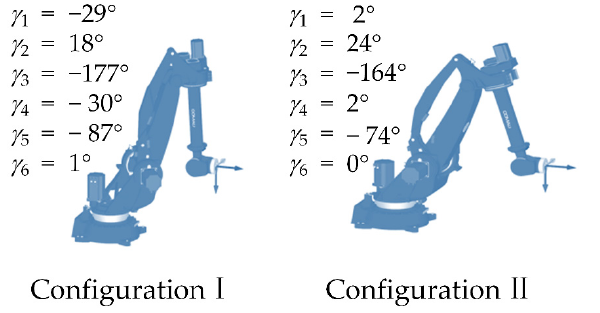
Figure 3. Robot configurations chosen for experimental verification. Table 1. Milling parameters and the chatter state.